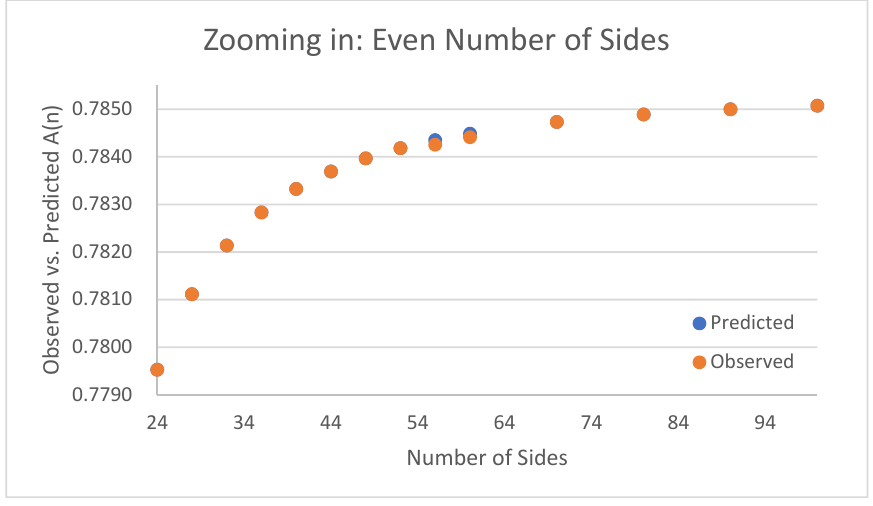
Figure 9. Zooming in: observed vs. predicted 𝐴(𝑛) results applying the regression model (10) for even 24 ≤ 𝑛 ≤ 100 .